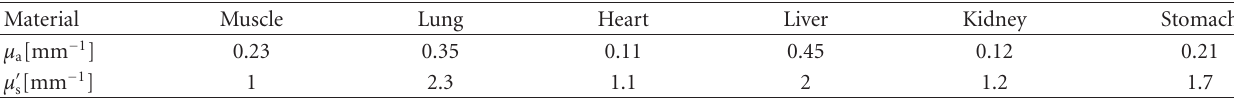
Table 3: Optical properties for the atlas organs